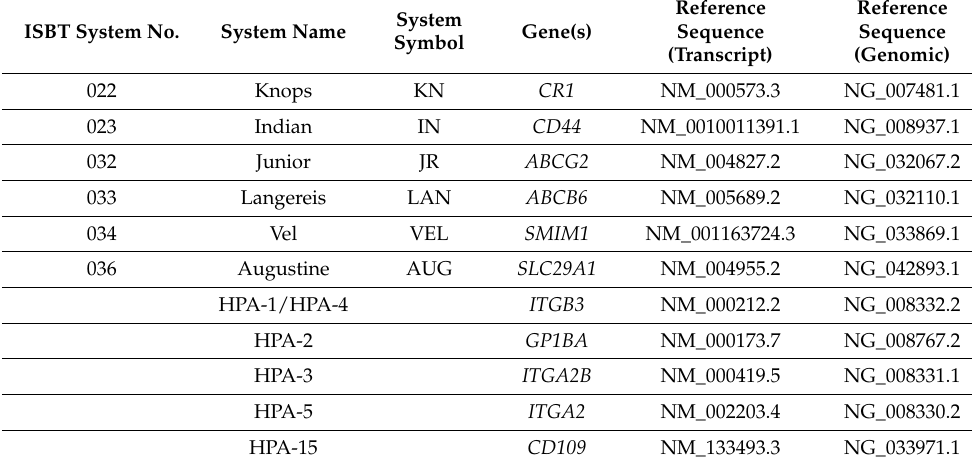
Table 1. Cont . ISBT System